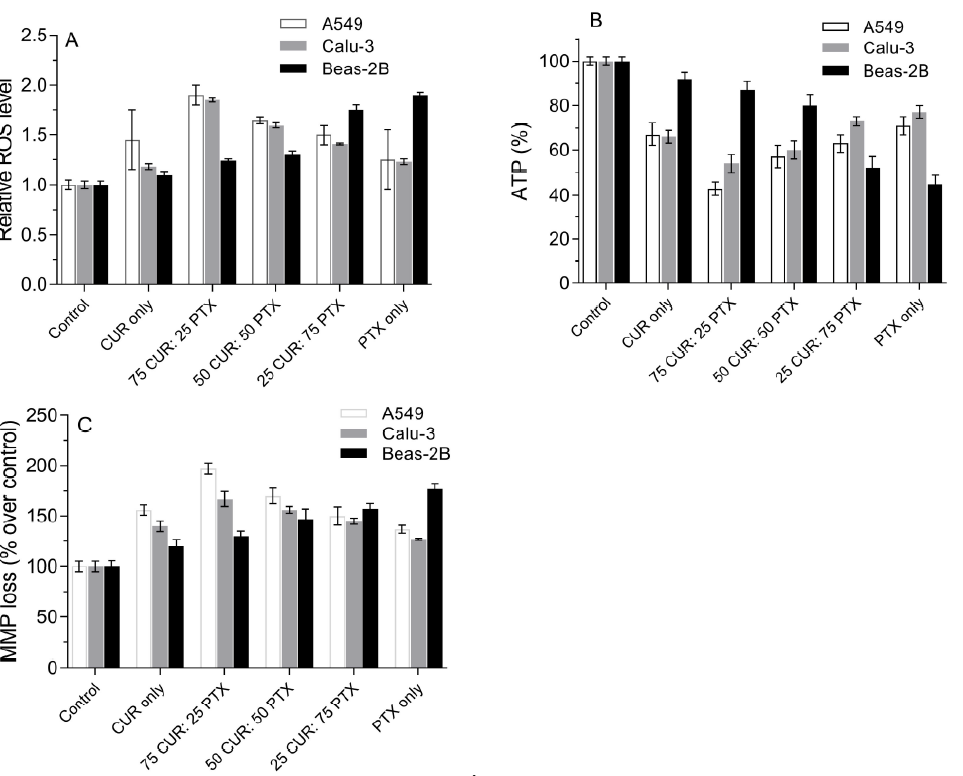
. Figure 7. Effect of CUR, PTX and CUR/PTX combination formulations on the ( A ) intracellular ROS level, ( B ) ATP levels and ( C ) MMP depletion in A549, Calu-3 and Beas-2B. Control indicates untreated cells. Data are expressed as mean ± SD of three